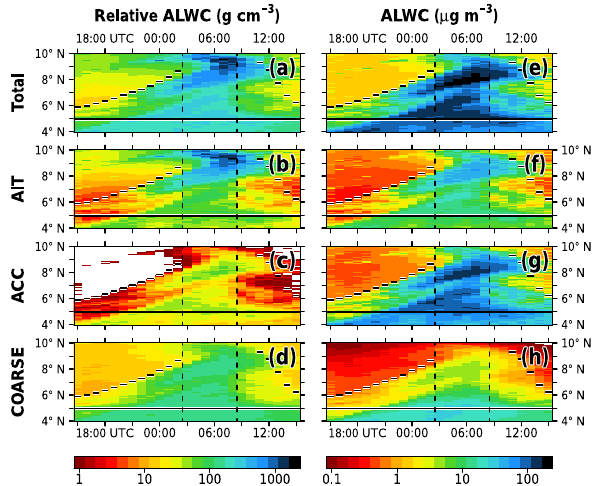
15:00 UTC. The black bars denote the location of the 302